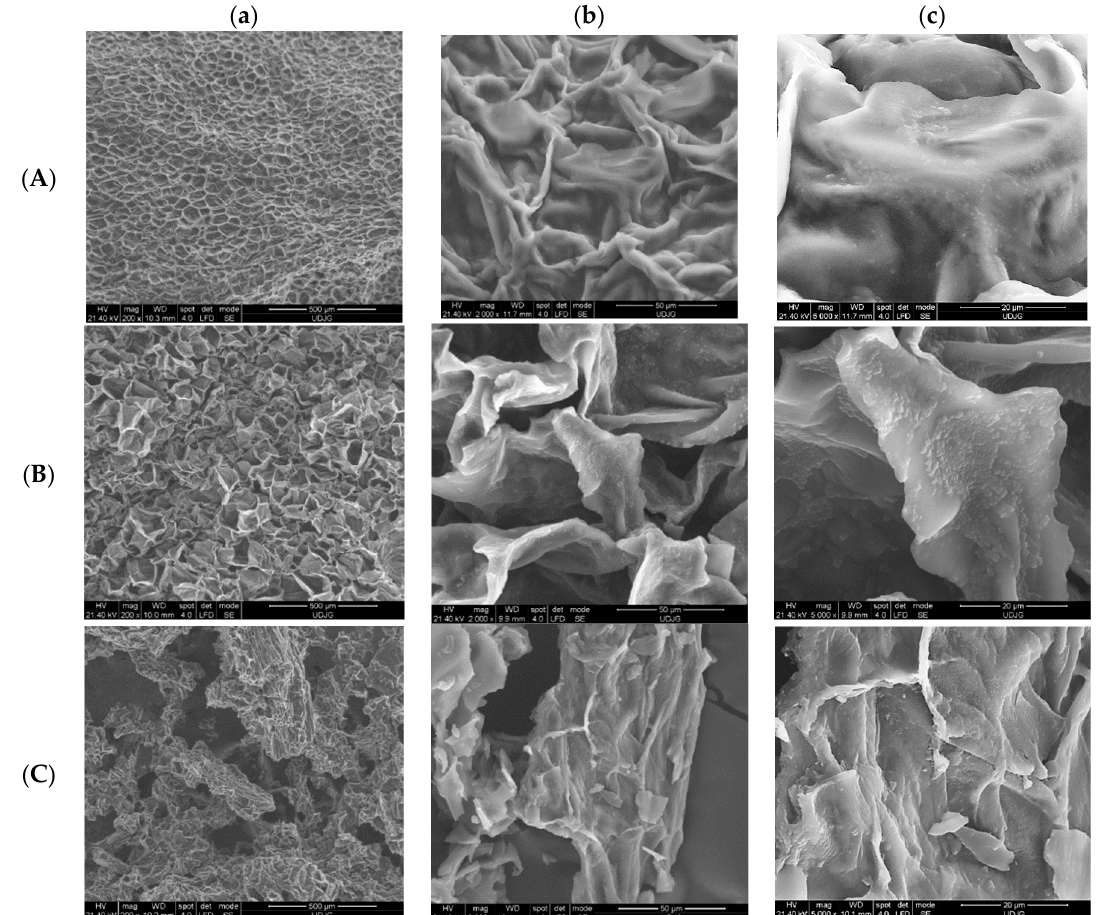
Figure 2. SEM images of the samples’ ultrastructure: ( A )—fresh cubes with lactic acid bacteria (LAB); ( B )—dried chips with LAB; ( C )—freeze-dried powder with LAB; ( a )—200×, ( b )—2000×, ( c )—5000×.